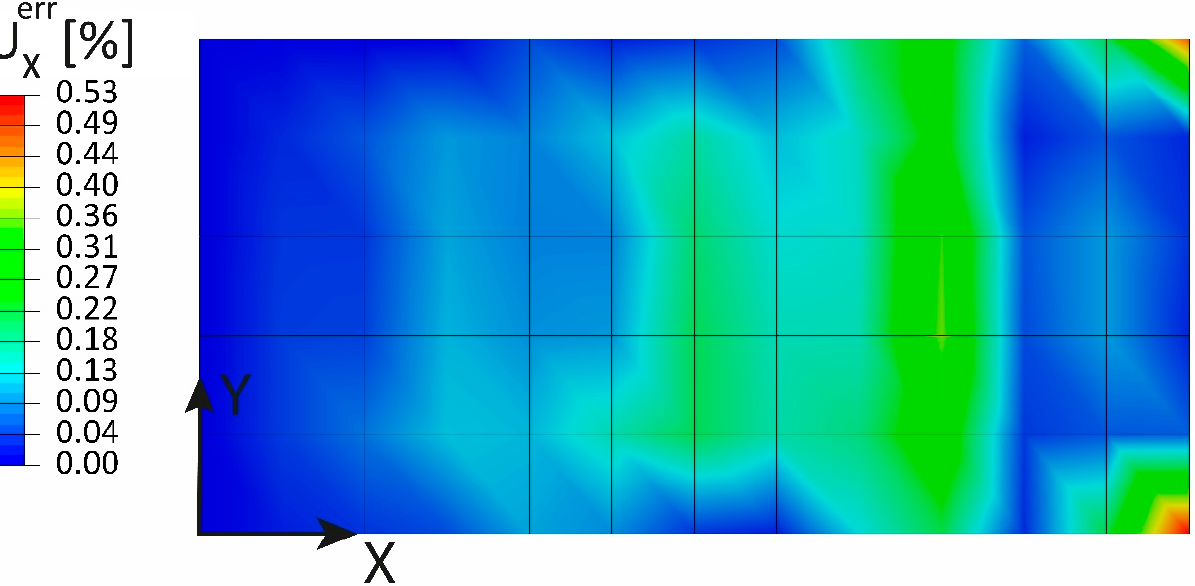
Figure 8 . Traction: percentage error of the 𝑈 (cid:3025) displacement. Figure 8. Traction: percentage error of the U X displacement.